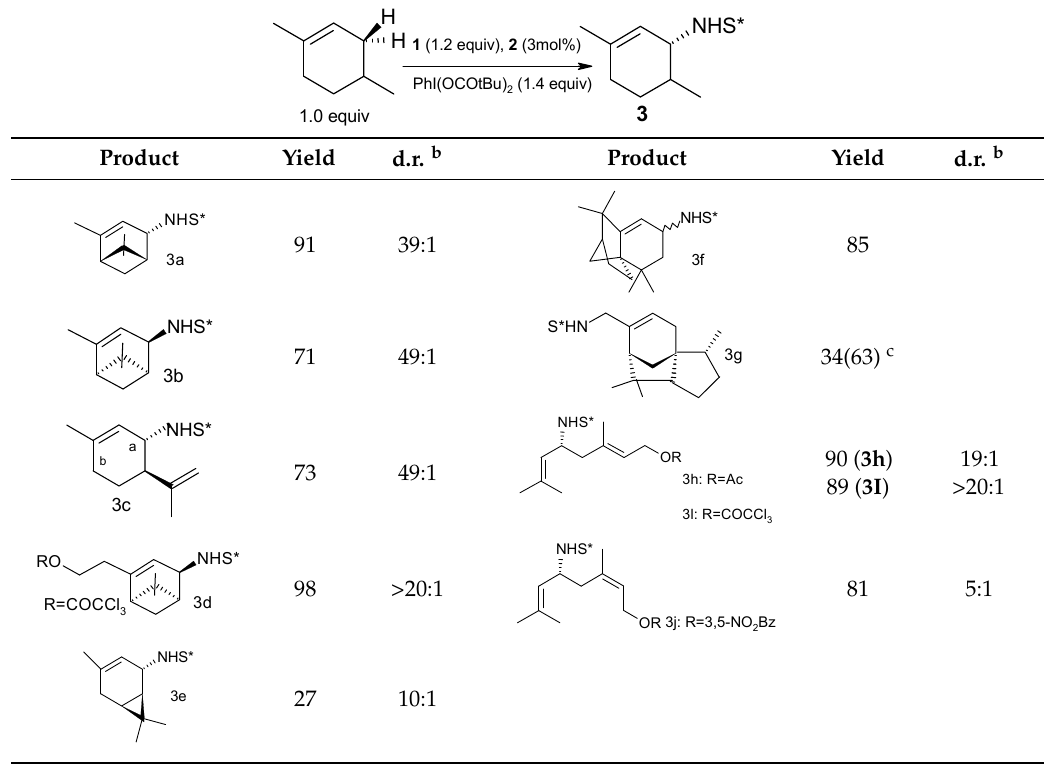
Table 14. Allylic amination of terpenes with sulfonimidamide S*NH 2 ( 1 in Figure 28) a . Adapted from [143].